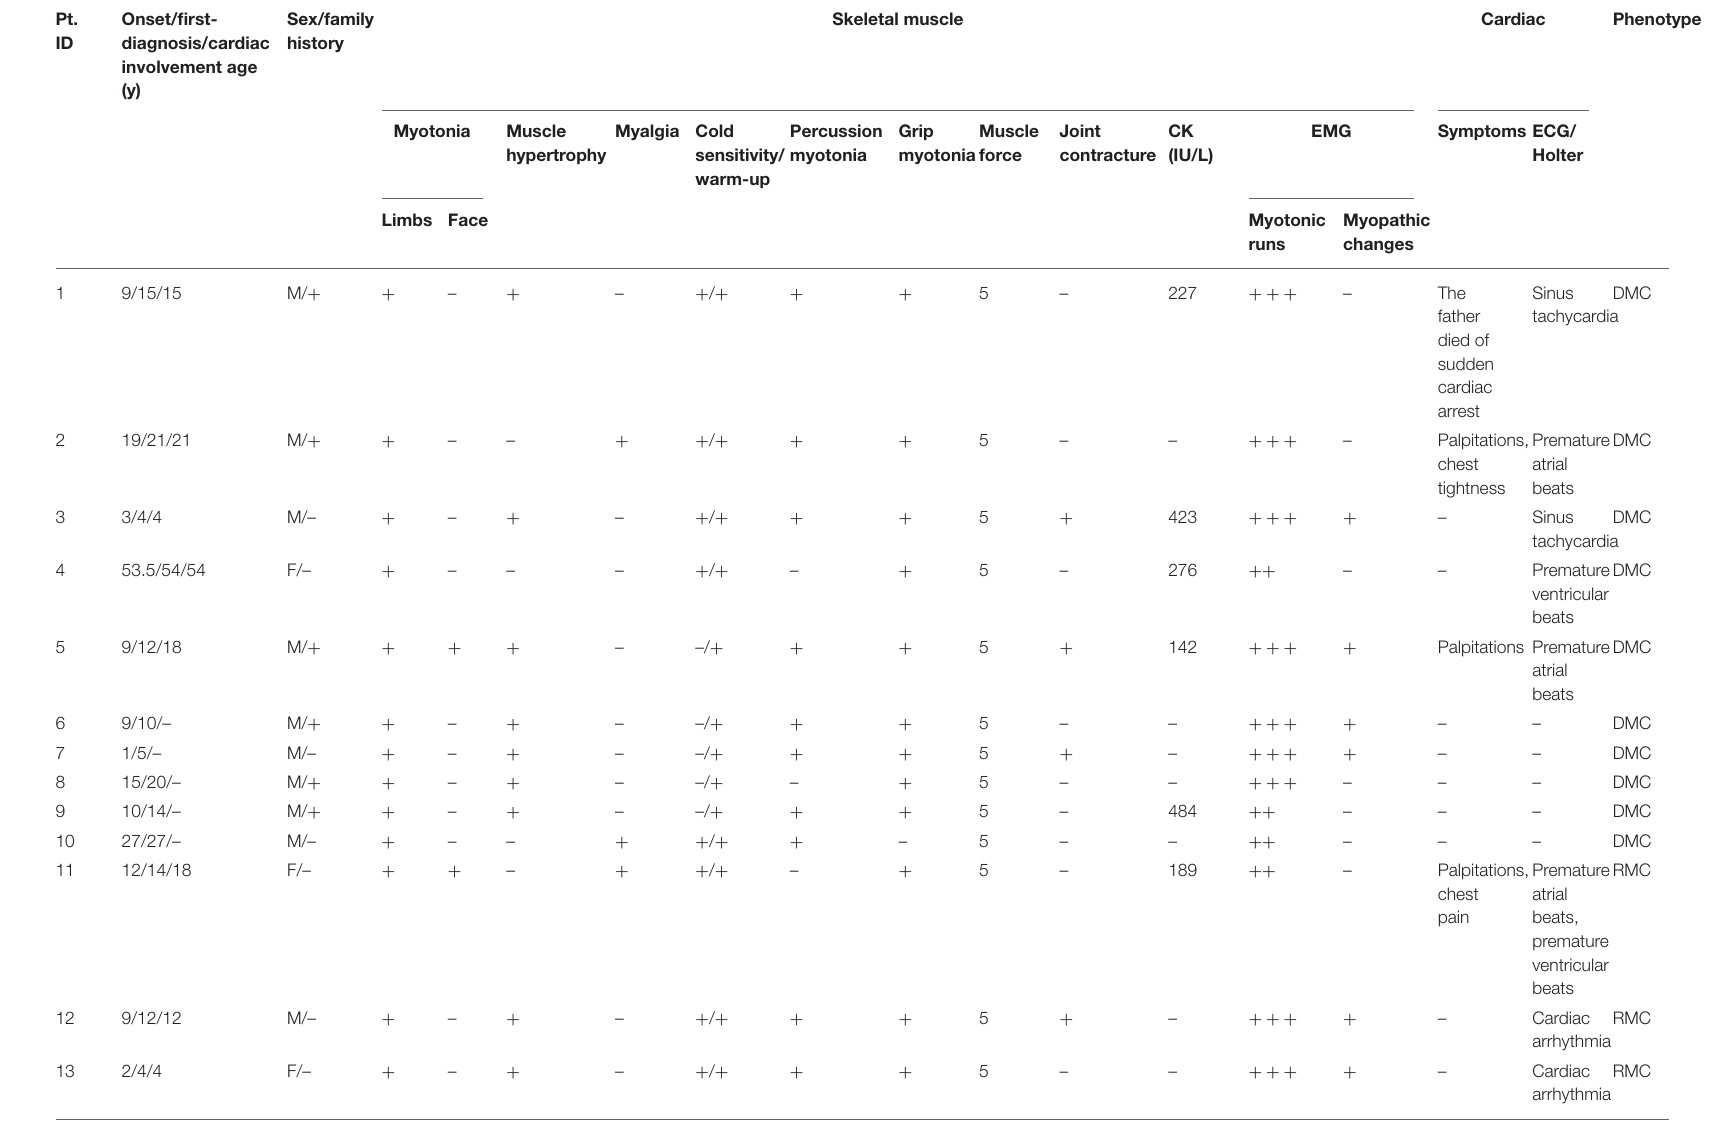
TABLE 1 | Clinical, laboratory, electrocardiogram, and electromyography data of 20 patients with non-dystrophic myotonia. Pt.